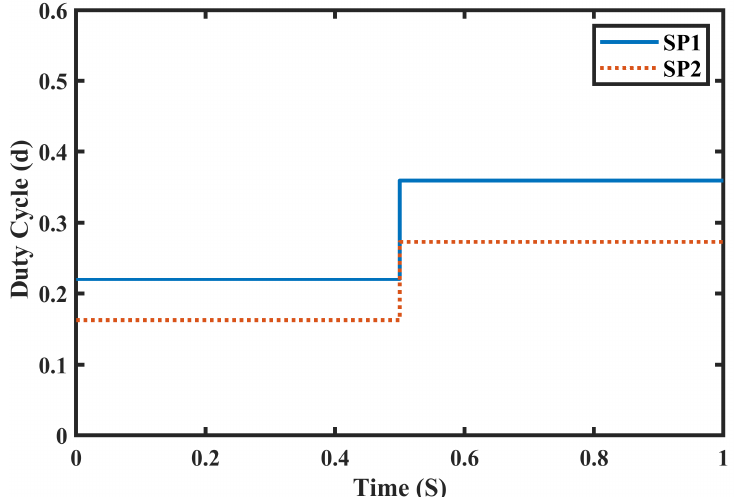
Figure 17. Duty cycle at SP1 and SP2.